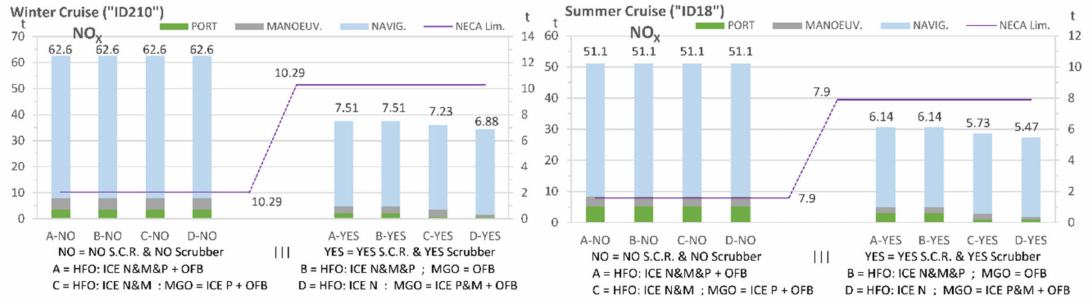
Figure 18. NOx emissions values, calculated for the winter / summer cruise, with di ff erent strategies for the usage of fuel and abatement